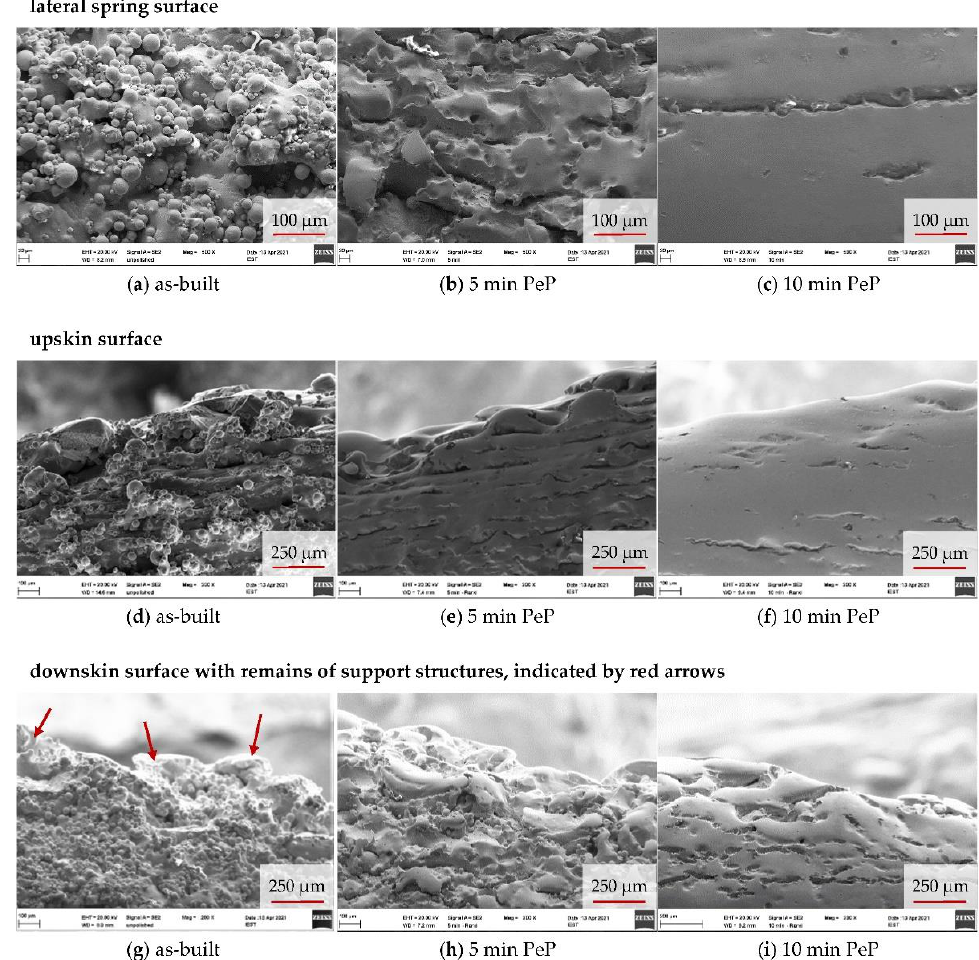
Figure 5. SEM images of detailed surface features on the up- and downskin of the spring: comparison of the as-built LBM sample to the springs after 5 min and 10 min of PeP.